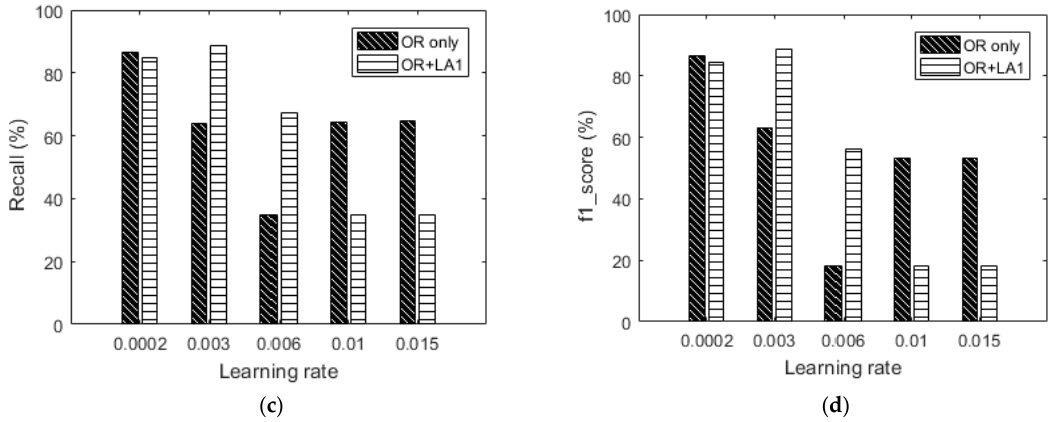
Figure 17. UCI’s 128-feature vector dataset: ( a ) Accuracy versus learning rate, ( b ) precision versus learning rate, ( c ) recall versus learning rate and ( d ) f1_score versus learning rate.